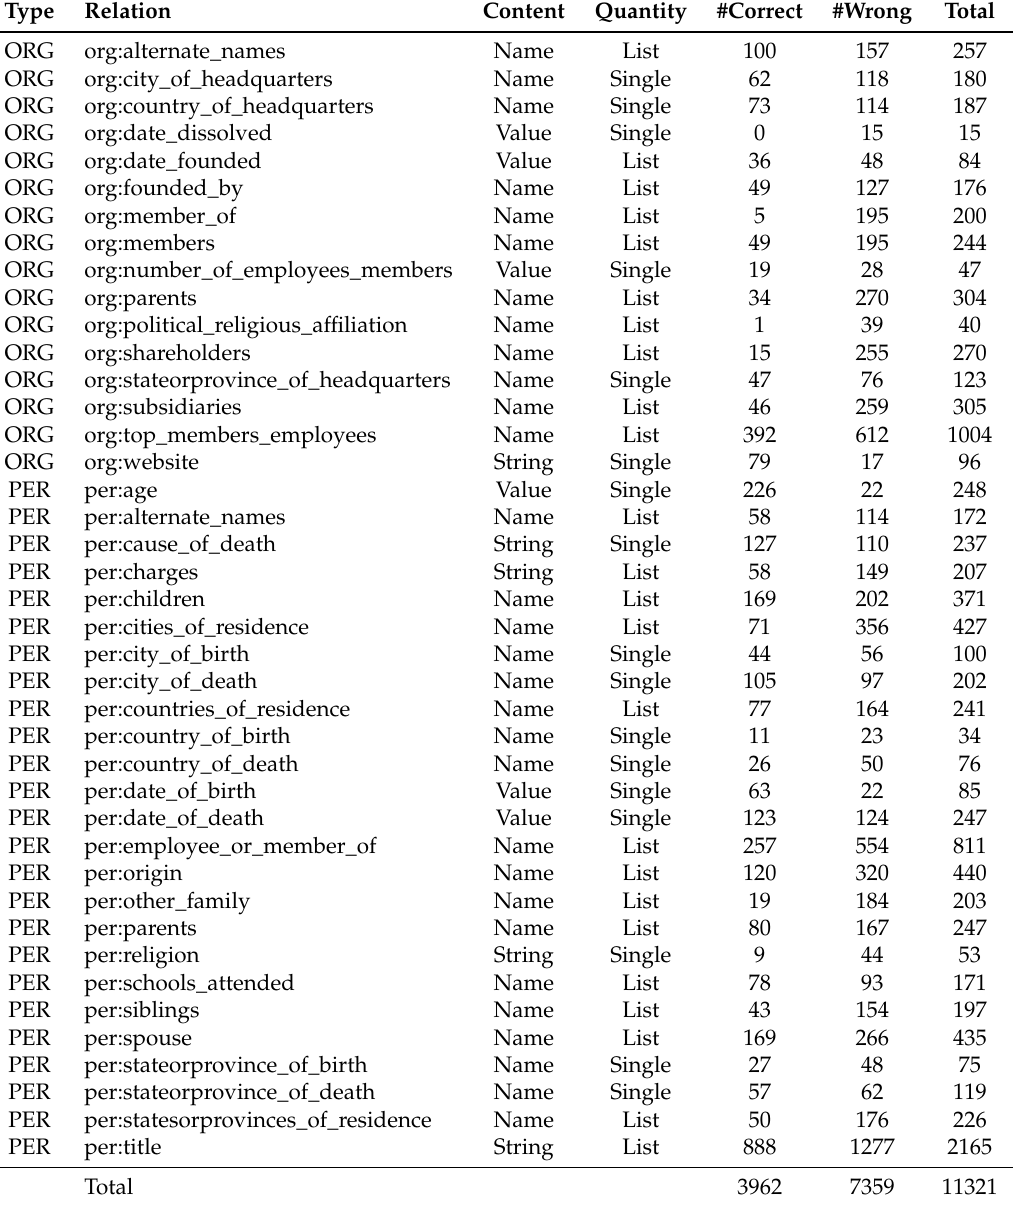
Table 1. List of 41 pre-defined relations in TAC KBP 2013 English Slot Filling track and their categorization